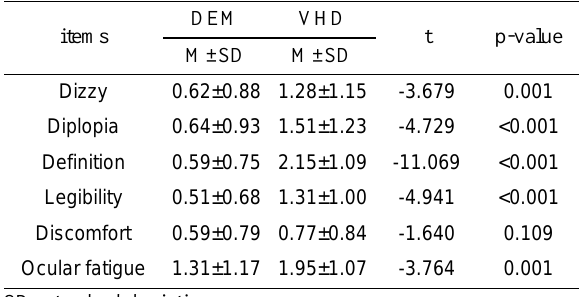
Comparison of DEM and VHD